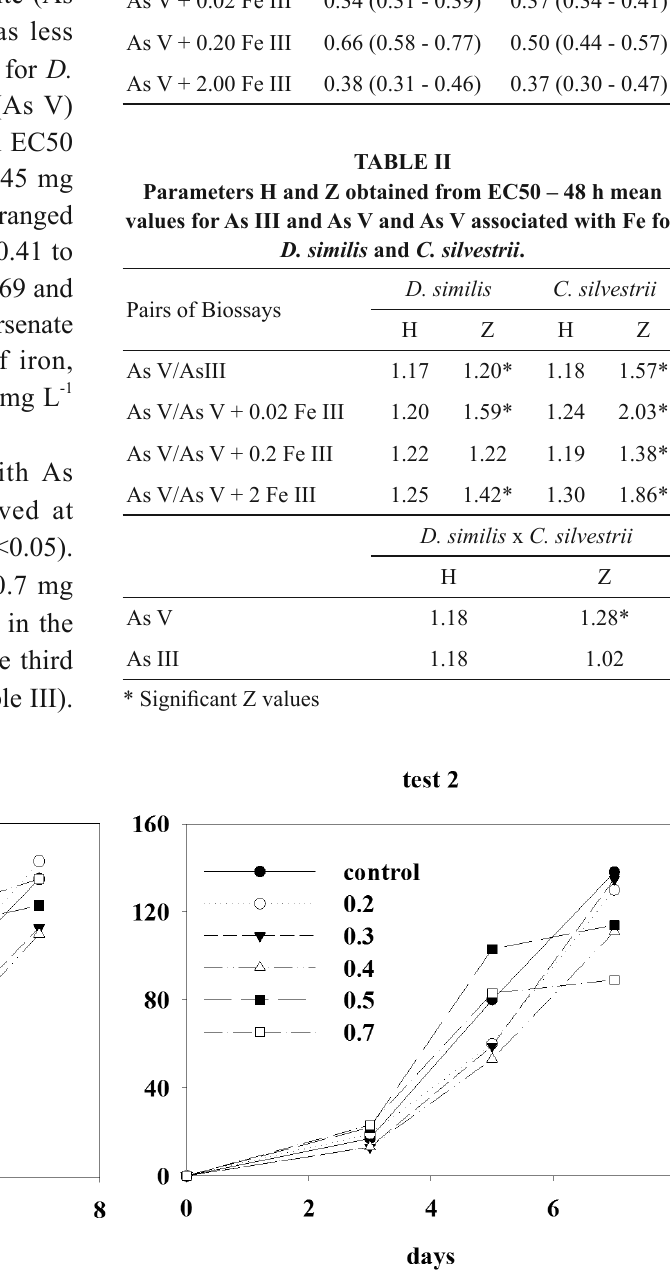
Figure 1 - Total neonates of C. silvestrii in chronic arsenate toxicity